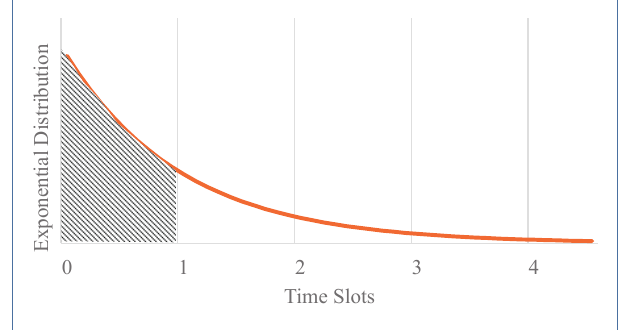
Figure 3. Illustration of calculating the transient state probability from an exponential duration distribution of a